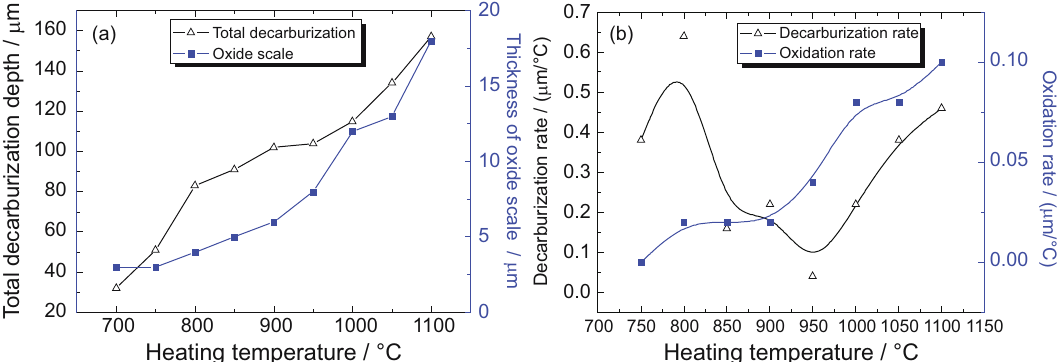
Figure 10: Comparison of surface decarburization and oxidation changes: ( a ) depth and ( b )